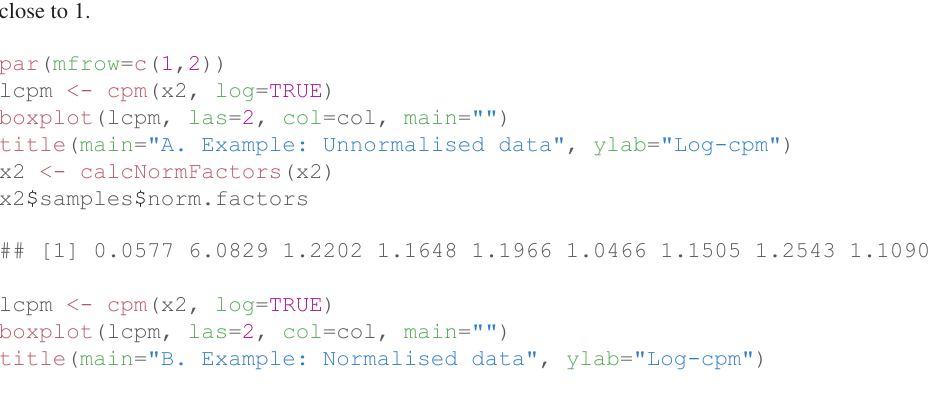
correspond to the leading fold-change, which is the average (root-mean-square) log most divergent between each pair of samples by